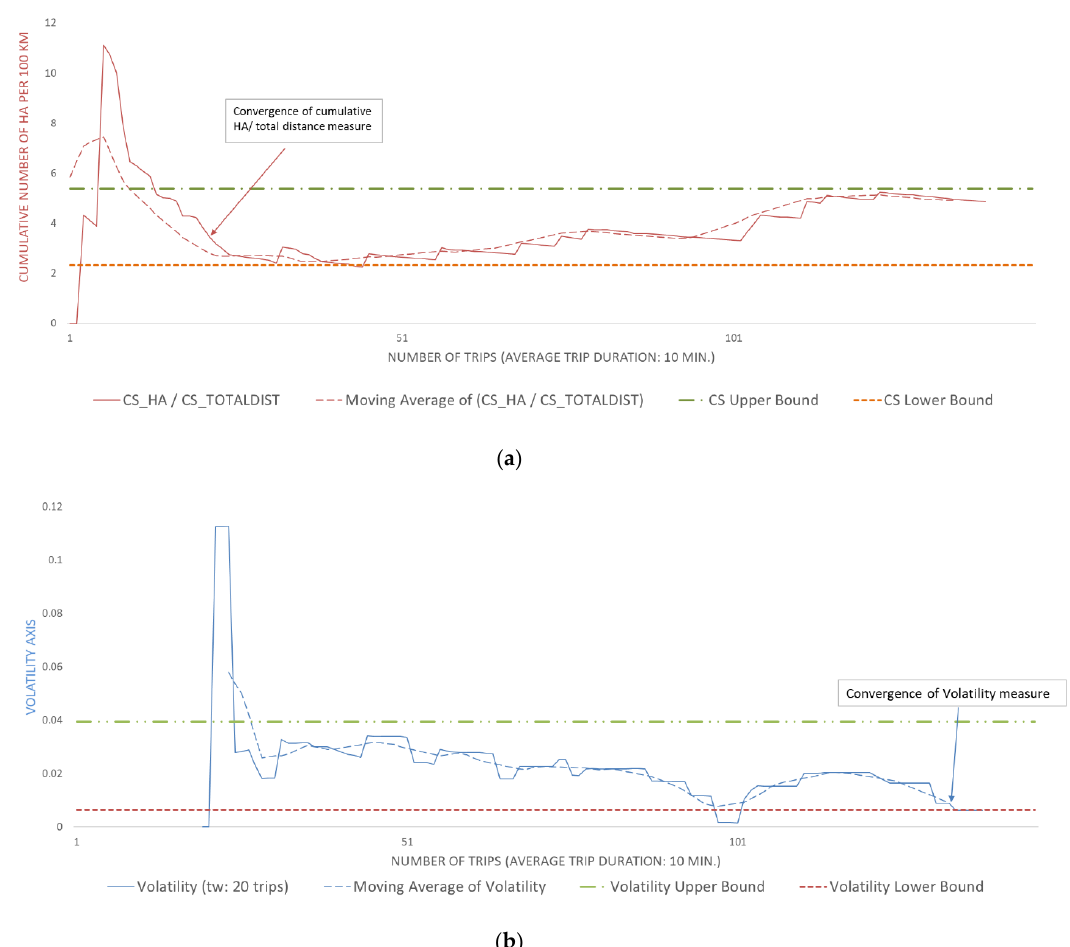
Figure 7. ( a ) Convergence plot of the cumulative harsh acceleration events per km for user “154.” ( b ) Convergence plot of the volatility of harsh acceleration events rate for user “154.”